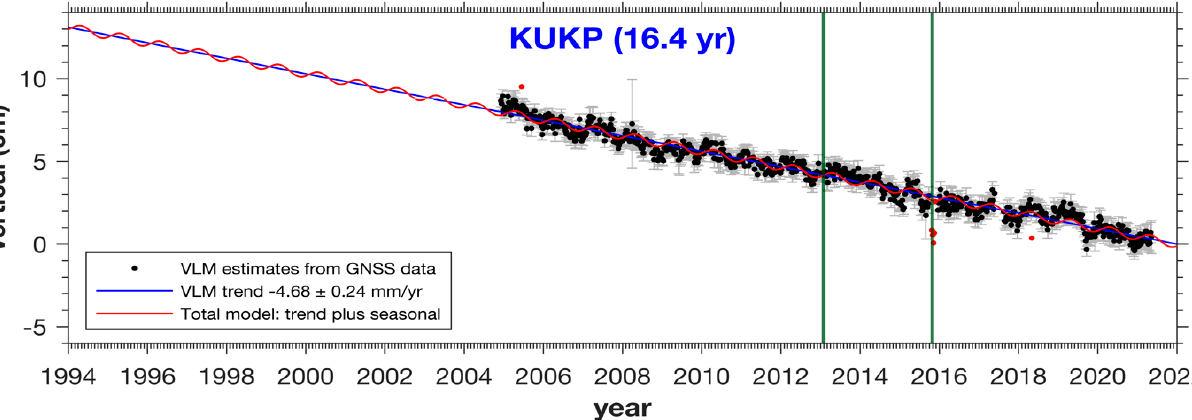
Figure 8. Vertical land motion (VLM) estimates at Kukup GNSS station (KUKP) from 1994 to 2021. Table 7. Final GPS benchmark geodetic coordinates from GIPSY-OASIS II solution and orthometric heights above PMGVD2000 and MSL2022B at tide gauge stations.